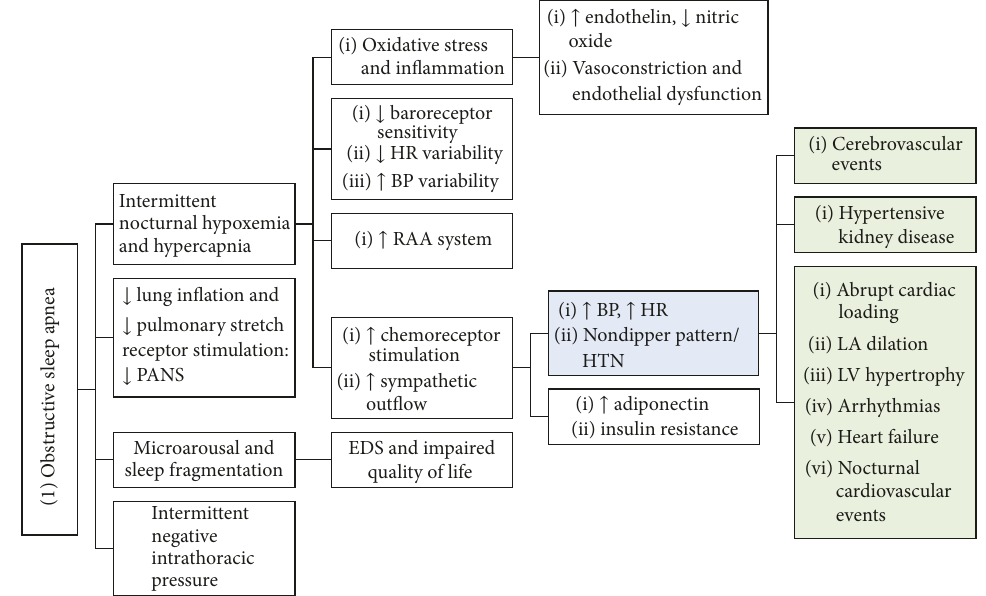
Figure 1: Mechanism of hypertension and end organ damage in obstructive sleep apnea. PANS, parasympathetic autonomic nervous system; RAA, renin-angiotensin-aldosterone; EDS, excessive daytime sleepiness; LV, left ventricular; LA, left atrial.